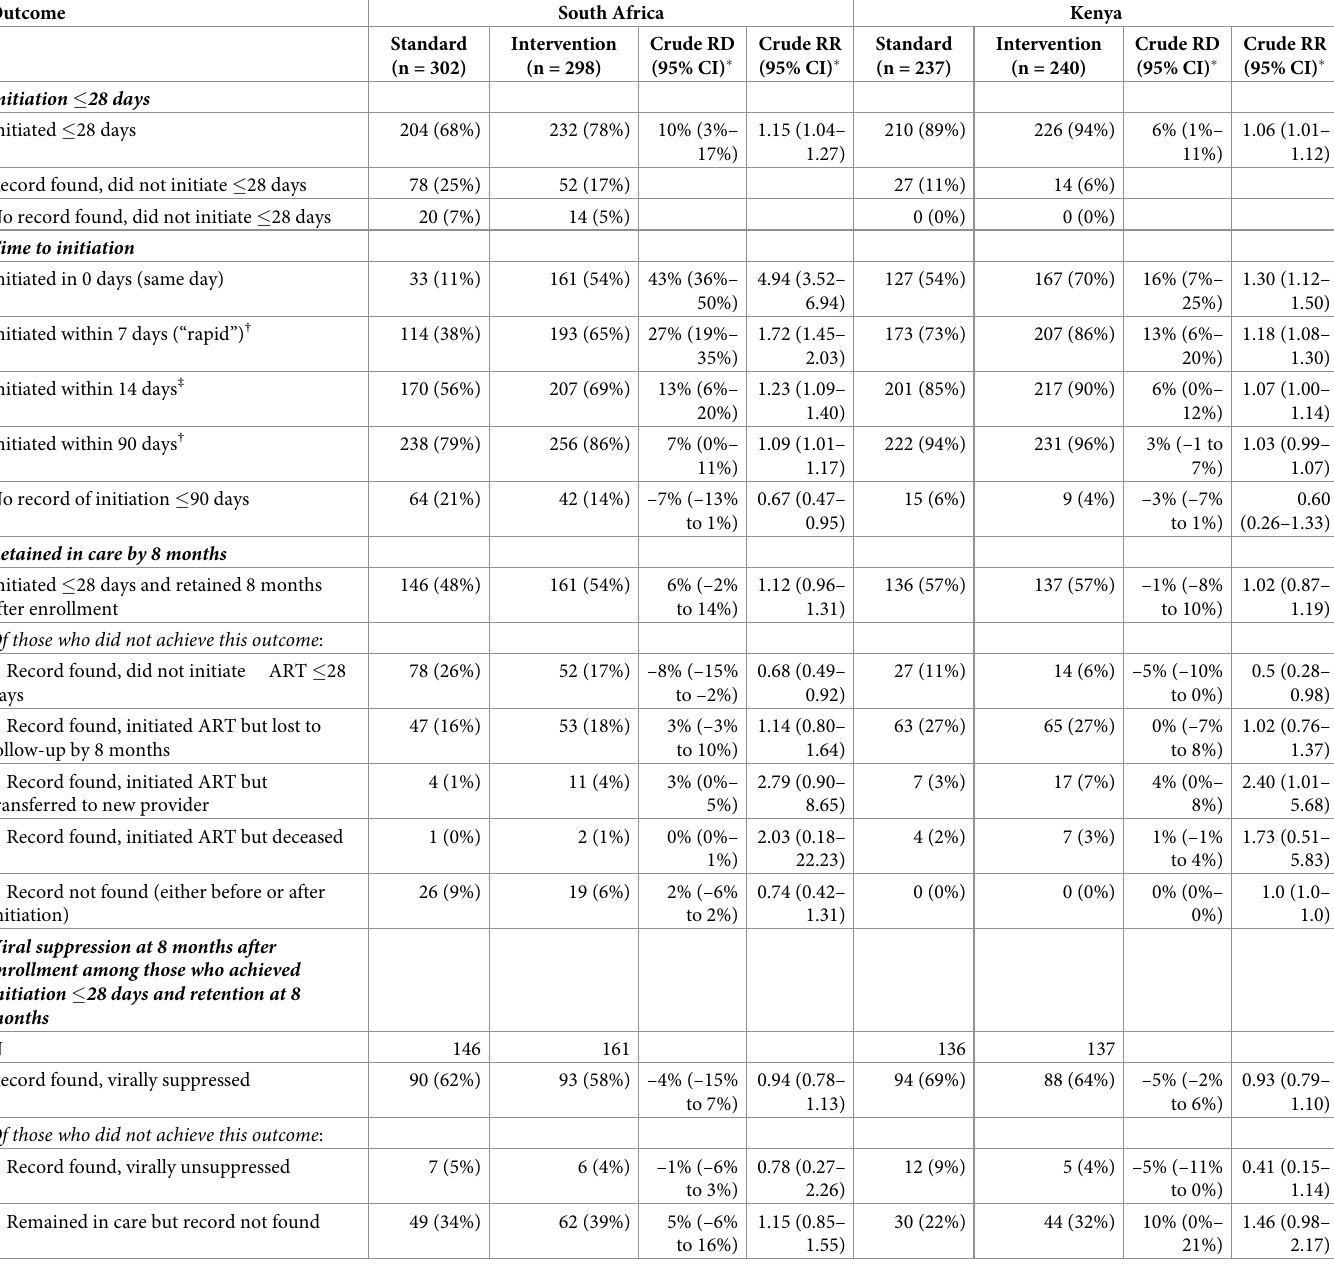
Table 2. Initiation, retention, and viral